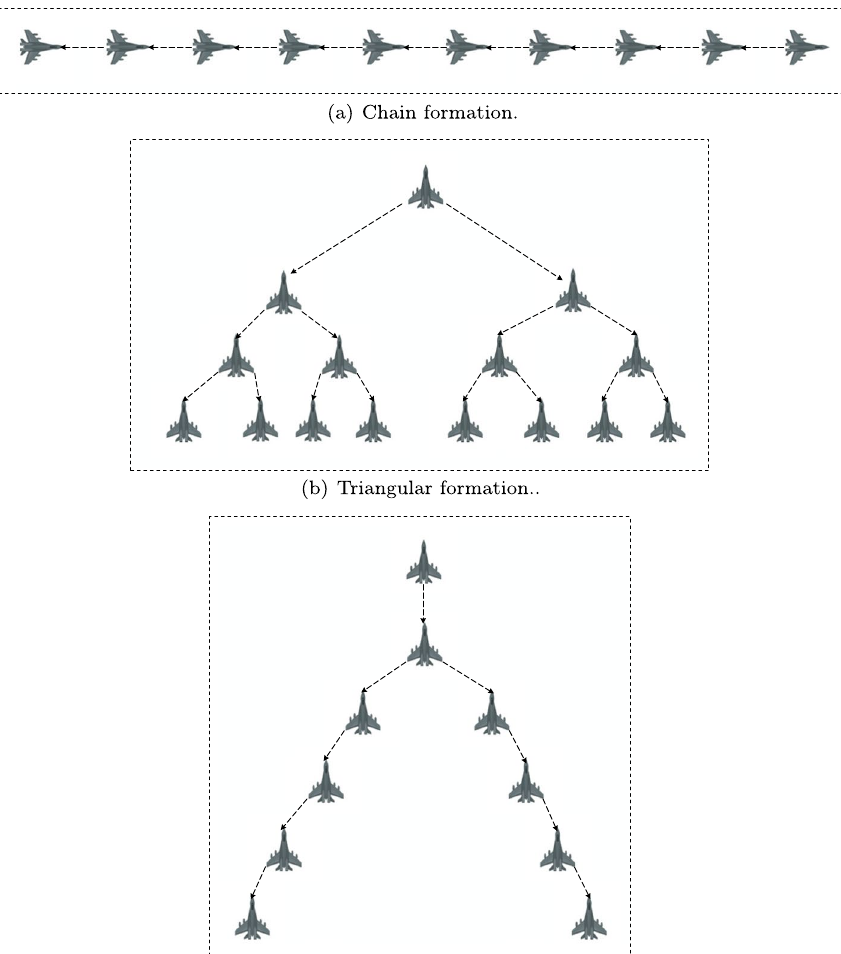
Fig. 7 Structures of subgroup